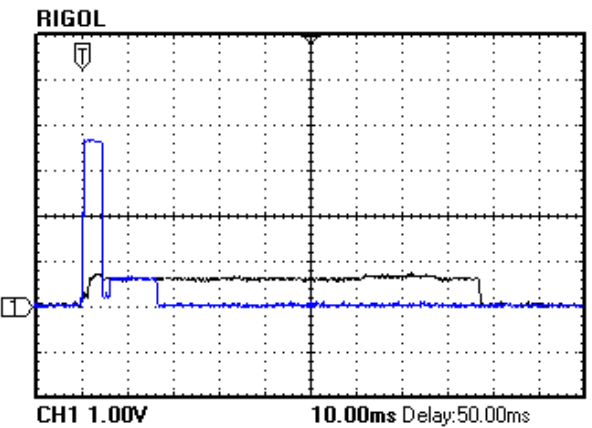
Figure 9. 500 samples of temperature data. Figure 9 . 500 samples of temperature data. Figure 9 . 500 samples of temperature data.